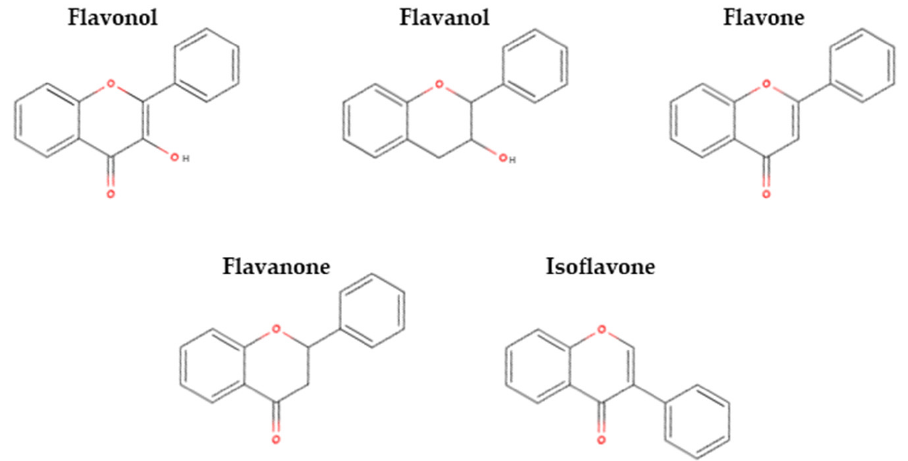
Figure 4. Chemical structures of the flavonoids (adapted from [87]).